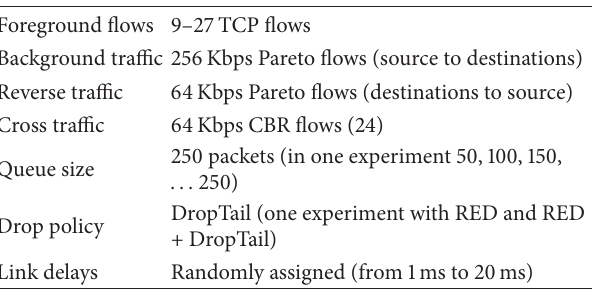
Table 1: Simulation